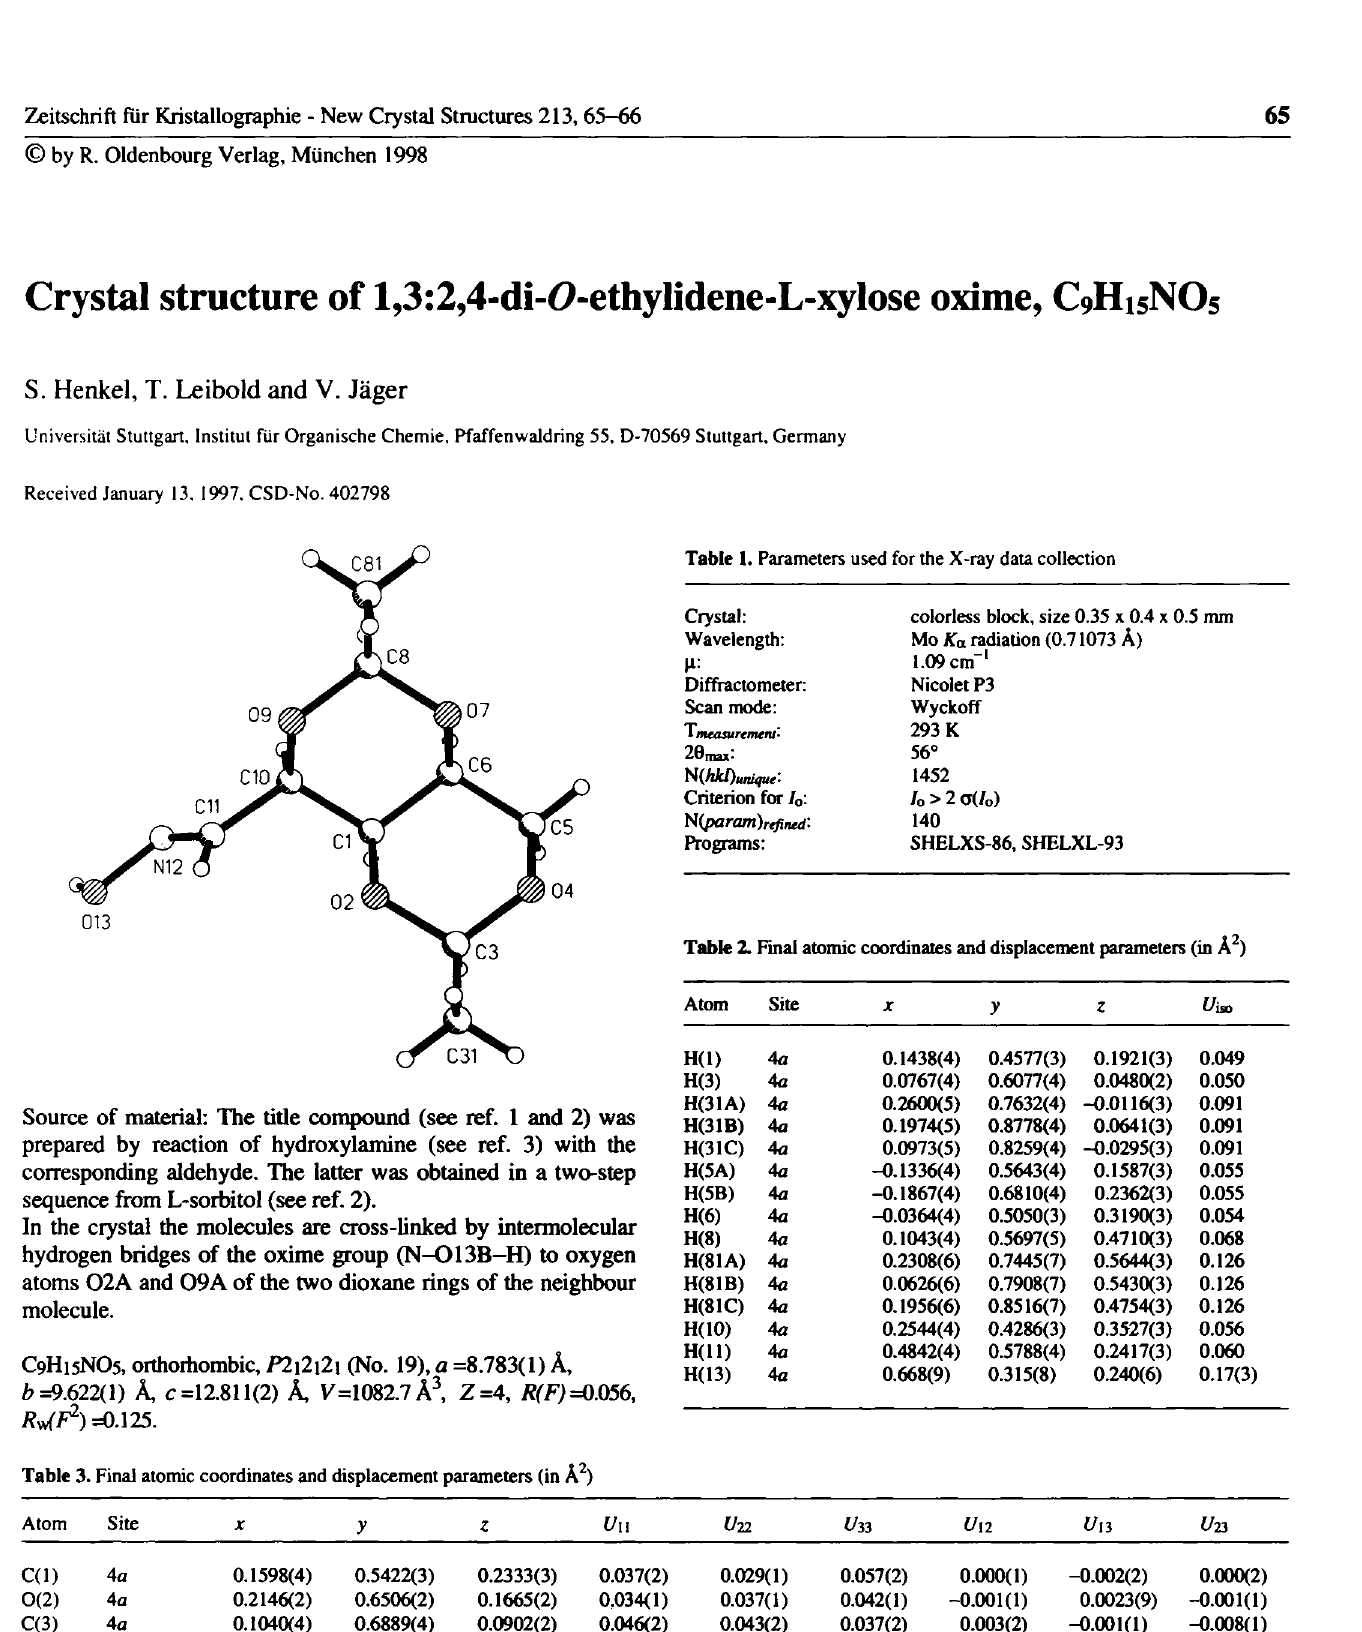
Table 3. Final atomic coordinates and displacement parameters (in λ^)